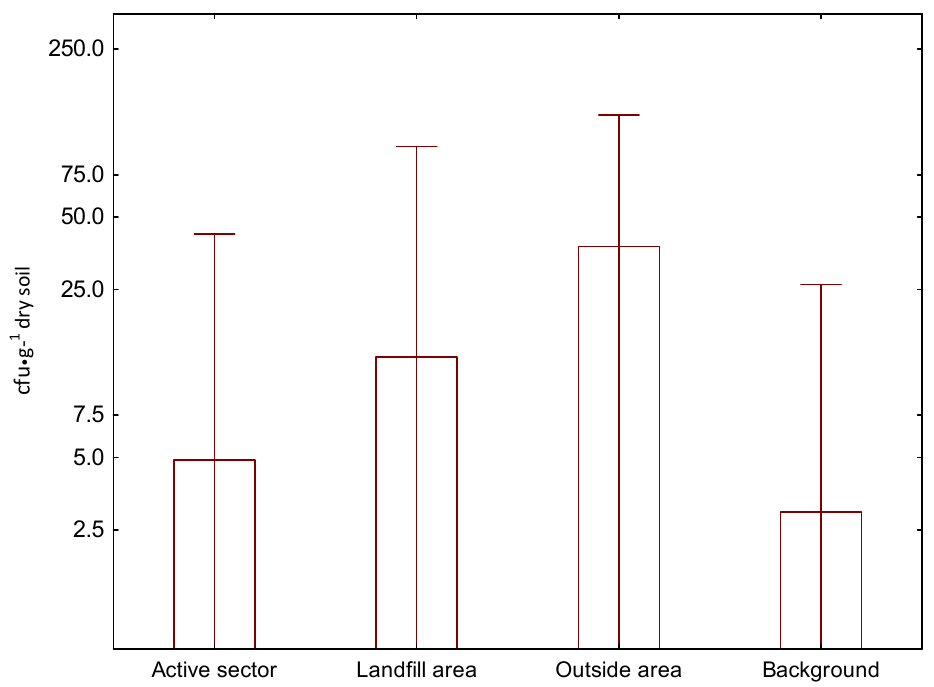
Figure 1. Average abundance (cfu g − 1 dry soil) of Salmonella spp. within the soil collected at three sampling areas of the municipal landfill. The background was arable soil located five kilometers west of stand 12. The data presented are means and standard deviation of two replicates.